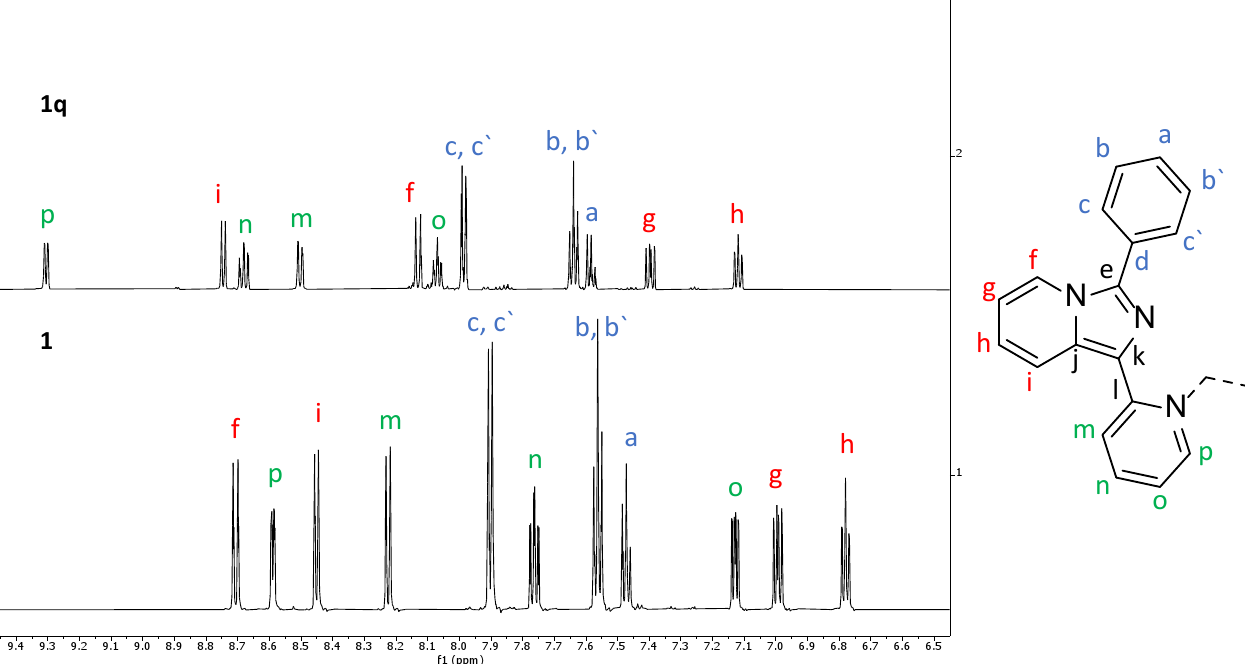
Figure 2. ( Left ): Aromatic region of the 1 H NMR spectra of 1 and 1q (Acetone-d 6 solution). ( Right ): Atom